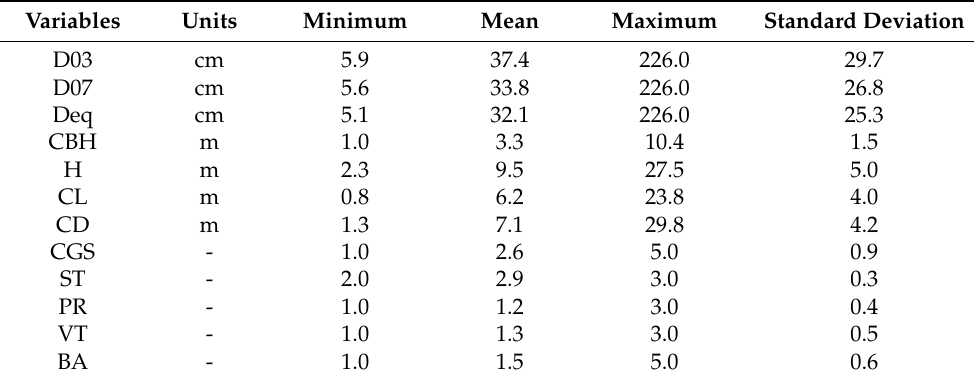
Table 2. Descriptive statistic of the variables measured in our sample. Variables